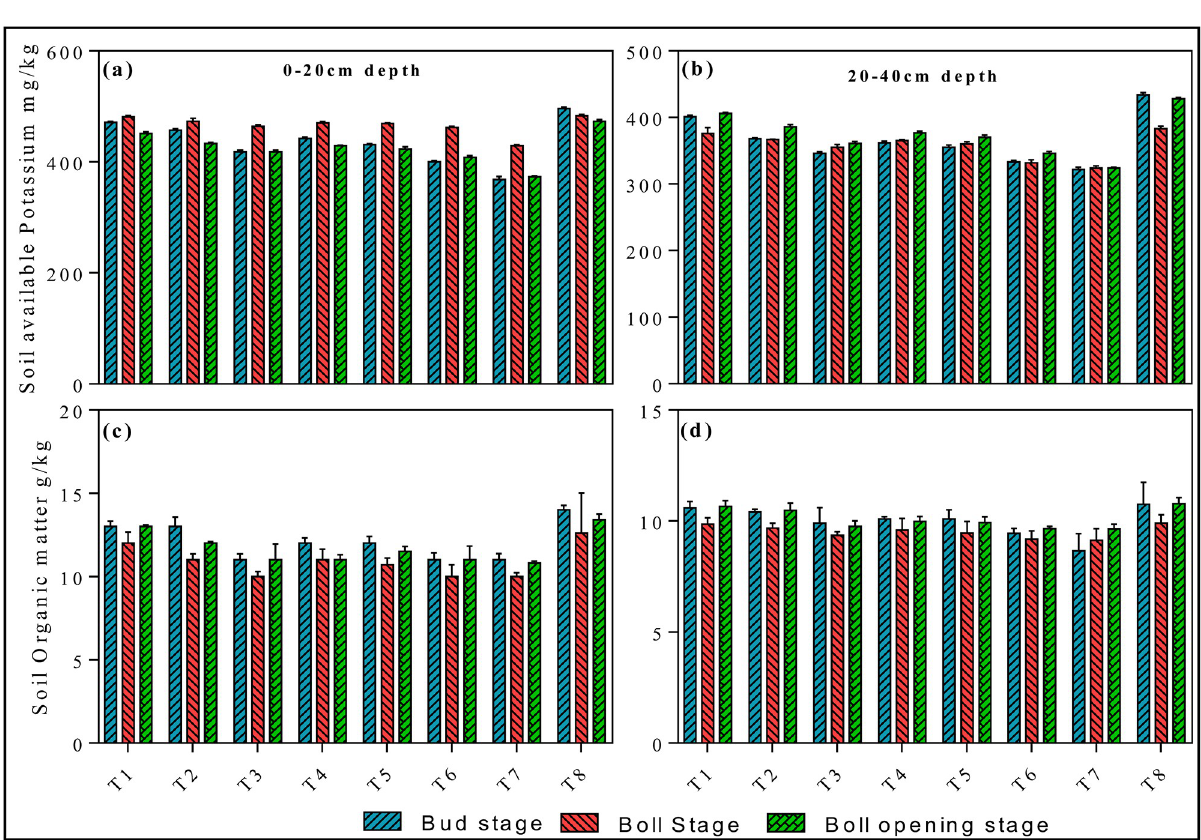
Fig 9. Effects of round irrigation on soil available potassium (mg/kg) and soil organic matter (g/kg): Fig (7a) and (7b) represents soil available potassium at depth of 0–20 cm and 20–40 cm; Fig (7c) and (7d) represents soil organic matter at depth 0–20 cm and 20–40 cm. Data were presented as the mean ± standard error (SE) of three replicates at a significance level of p < 0.05 (based on